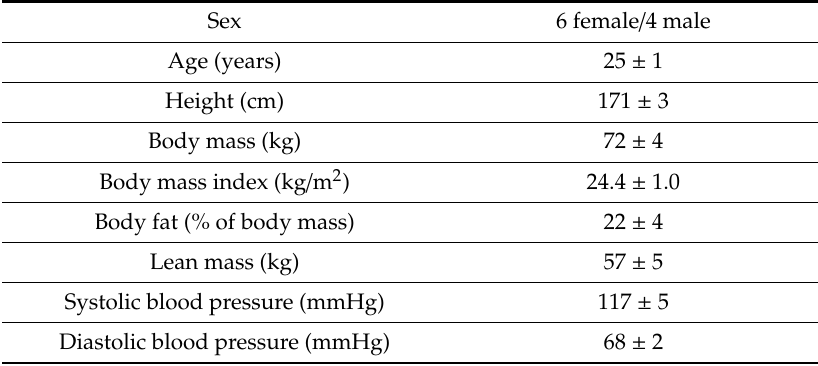
Table 1. Participants’ characteristics.